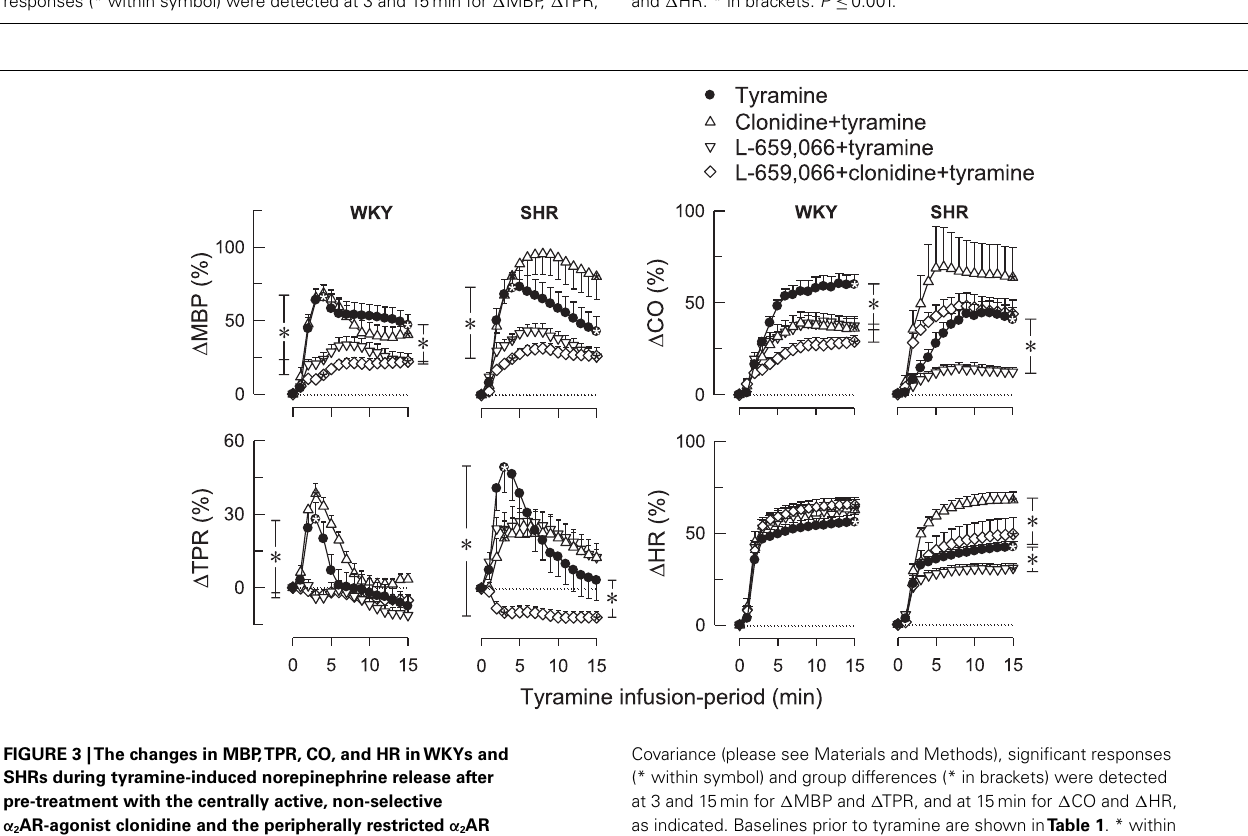
FIGURE 2 |The effect of the NET inhibitor desipramine and the muscarinic antagonist atropine on the cardiovascular response to tyramine. After curve evaluation using Repeated Measures Analyses of Variance and Covariance (please see Materials and Methods), significant responses (* within symbol) were detected at 3 and 15min for ∆ MBP, ∆ TPR,